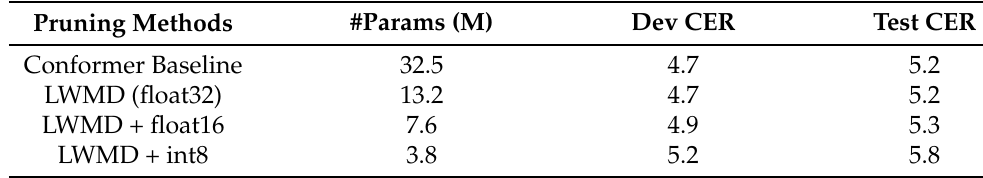
Table 5. Exploration results of low bit quantization on the LWMD platform. We try to introduce the float16 precision and the int8 precision into